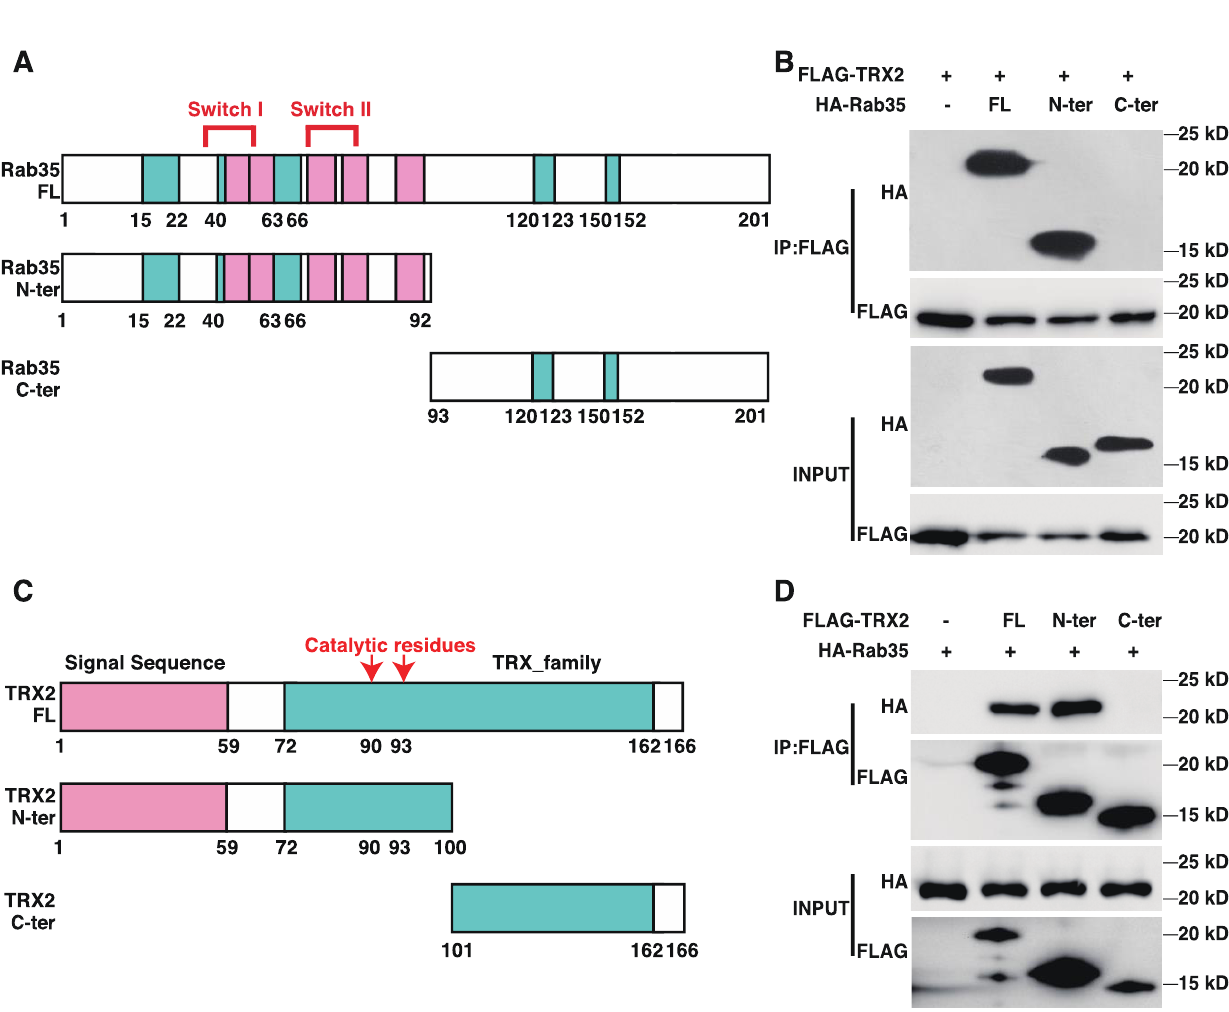
Figure 3. TRX2 and Rab35 bound to each other through N − terminal motifs. ( A ) Schematic diagram of Rab35. Amino acids 33 and 38 – 46 are switch I domain, and amino acids 66 and 68 – 78 are switch II domain. Green indicates the G box and pink indicates RABF, the Rab family motif. Amino acids 1 – 92 are the truncated N − terminal (N − ter) region of Rab35, which contains the switch domain. Amino acids 93 – 201 are the truncated C − terminal (C − ter) domain of Rab35. ( B ) HCT116 cells were transfected with FLAG − tagged full − length (FL) TRX2 and HA − tagged full − length Rab35, Rab35 N − ter, or Rab35 C − ter. After 72 h, coimmunoprecipitation was performed with anti − FLAG beads. The pellet was analyzed by WB. ( C ) Schematic diagram of TRX2. In the pink region, amino acids 1 – 59 represent the signal peptide (to mitochondria). In the green region, amino acids 72 – 162 represent the thioredoxin family domains. The 90th and 93rd amino acids are the catalytic active sites of TRX2. The 1st to 100th amino acids are the truncated N − terminal (N − ter) region of TRX2, which contains the signal sequence and catalytic active sites. ( D ) HCT116 cells were transfected with HA − flagged Rab35 and FLAG − tagged full − length TRX2, TRX2 N − ter, or TRX2 C − ter. After 72 h, coimmunoprecipitation was performed with anti − FLAG beads. The pellets were analyzed by WB. The experiments were performed for three biological